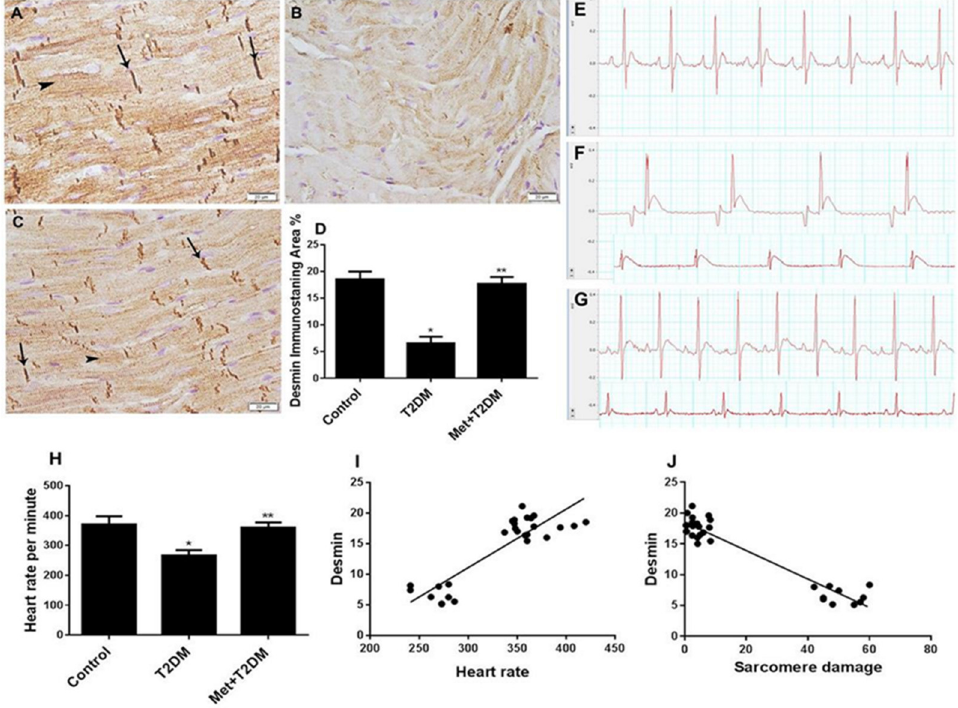
Figure 3. Metformin (Met) protects against the inhibition of cardiac desmin expression and ECG abnormalities caused by T2DM. Immunohistochemistry of desmin (400×) in left ventricle sections obtained 10 weeks post diabetic induction from the untreated control ( A ), T2DM ( B ), and Met + T2DM ( C ) groups are depicted (Scale = 20 μ m). Note that the arrows in ( A , C ) point to desmin immunostaining in the intercalated discs, and the arrowheads in ( A , C ) point to the organized desmin distribution in the cardiomyocytes. Histograms in ( D ) represent a quantitative analysis of desmin-immunostained area % in cardiac sections from the above groups. Representative ECG recordings from the untreated control ( E ), T2DM ( F ), and Met + T2DM ( G ) groups are depicted. The heart rate of the groups was recorded at the end of the experiment ( H ). ( I , J ) Correlation between desmin and heart rate ( I ) and sarcomere damage ( J ). T2DM: type 2 diabetes mellitus; ECG: electrocardiographs. Presented p values are all significant. * p < 0.0001 versus control, ** p < 0.0001 versus T2DM.